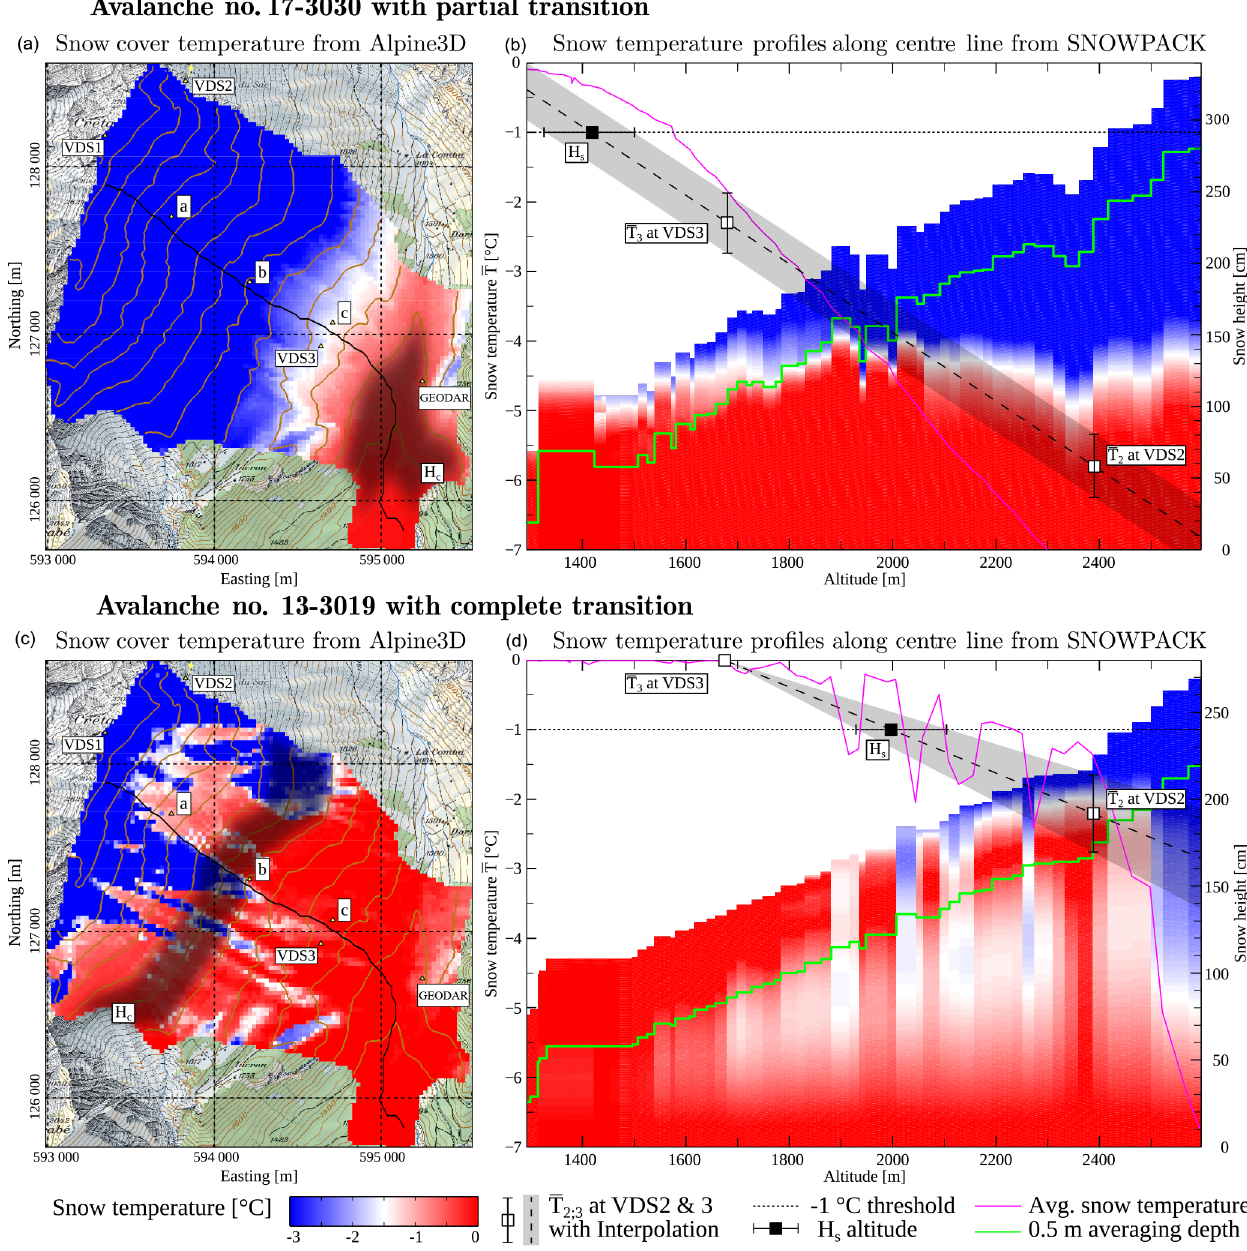
Figure 1. Snow cover simulations for avalanche no. 17-3030 with partial transition (a, b) and no. 13-3019 with complete transition (c, d) . The left panels (a, c) show the averaged temperatures T of the uppermost 0.5m snow cover from Alpine3D gridded over the VdlS catchment. The area overlay in grey denotes H s ± (cid:49)H s . For reference, the location of the pylon (c) and profiling radars (a, b) are shown. The right panels (b, d) show the snow temperature profiles along the path of steepest descent (black line in left panels a , b ). The purple curve indicates the average temperature T of the top 0.5m of each vertical profile. The T values at the top and bottom weather stations are shown with white squares together with the temperature variations. H s is calculated using linear interpolation between the weather stations as the intercept of grey area with − 1 ◦ C and shown with black